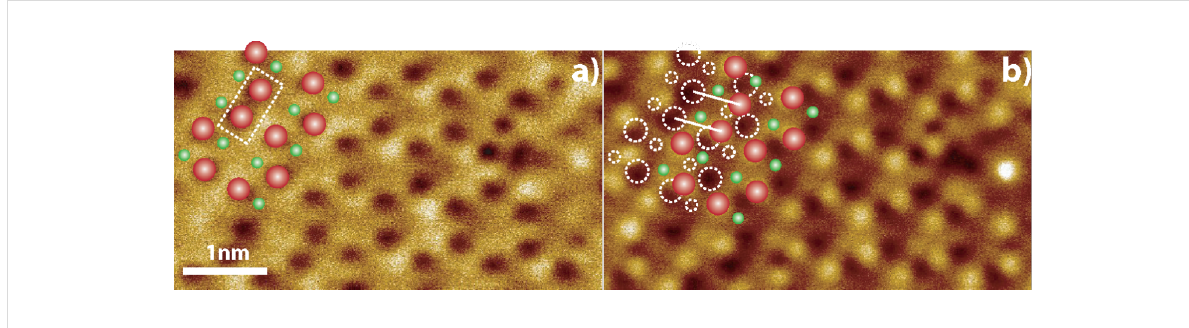
Figure 2: Larger scans of (a) inverted and (b) high-setpoint inverted images presented in Figure 1b and Figure 1c. In a) the large red (small green) circles indicate the apparent location of the up (down) atoms. In (b) the dotted outlines indicate the position of the atoms in the inverted image and the red (green) circles indicate the new apparent position of the up (down) atoms. Solid white lines link the inverted and noninverted images of the same